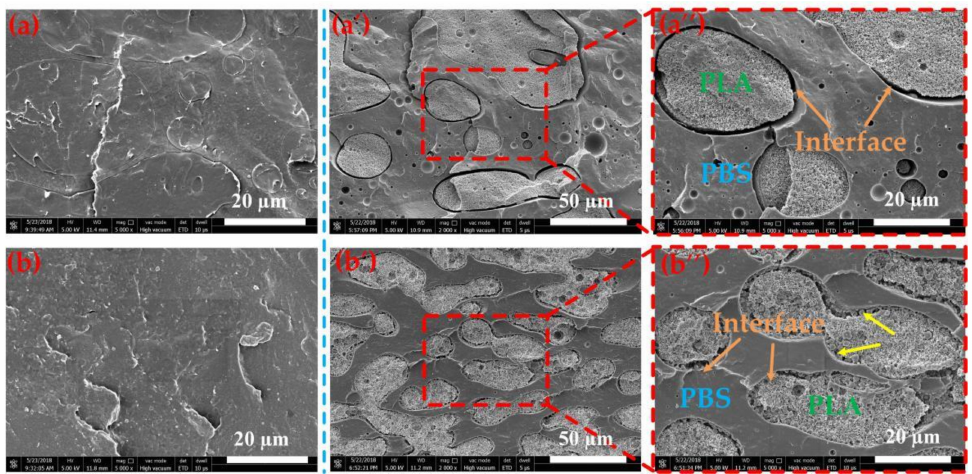
Figure 9. SEM images of cryofracture surfaces and PLA amorphous were etched cryofracture surfaces:( a – a” ) PLA/PBS 50/50; ( b – b” ) PLA/PBS/EGMA